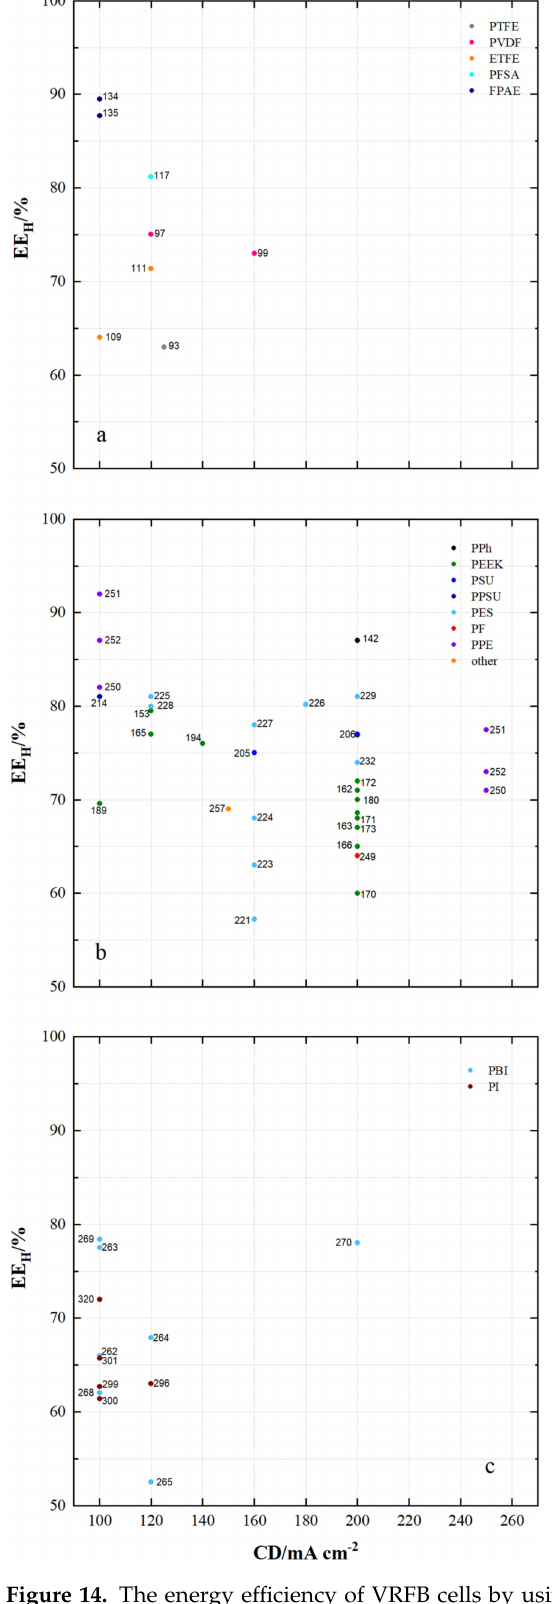
Figure 14. The energy efficiency of VRFB cells by using membrane samples at current densities ≥ 100 mA cm − 2 : ( a ) fluoro-carbons, ( b ) hydro-carbons and ( c ) N